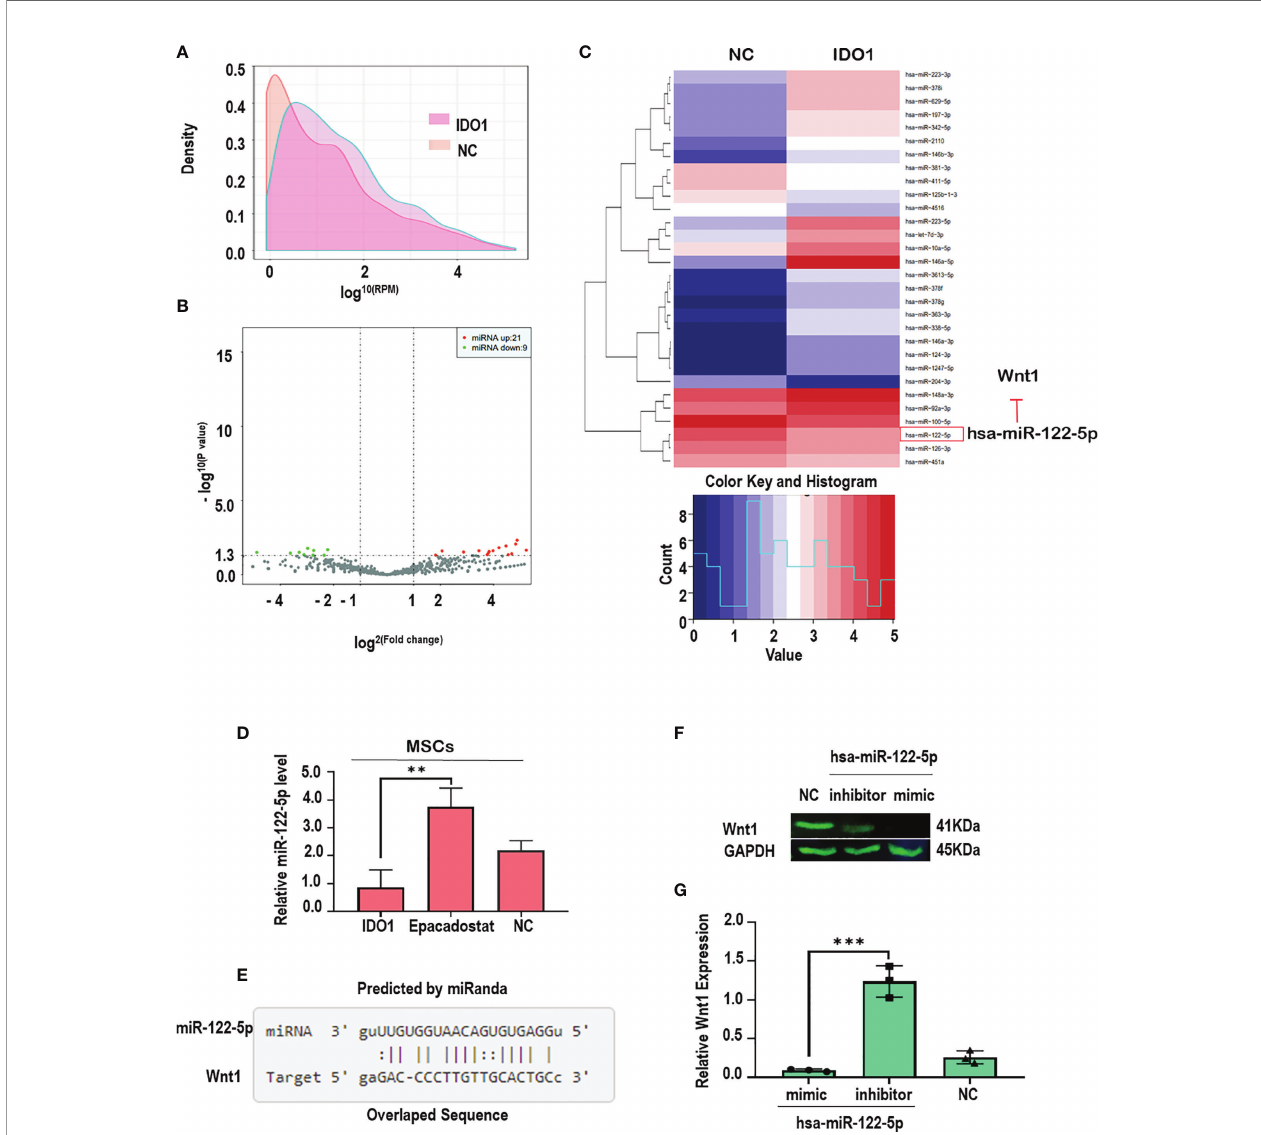
FIGURE 6 | IDO1 impairs chondrogenic differentiation of MSCs by activating Wnt1/ b -catenin throughdownregulation of miR-122-5p. (A,B) The density and distribution of miRNA inthe total RNA obtained from MSCs-treatedIDO1 compared to normal. (C) The screeningof up-/downregulated miRNA, which shows the downregulation ofmiR- 122-5p under the effectof IDO1. (D) The levelsofmiR-122-5p inthe MSCs treated with Epacadostat compared to IDO1 and NC cells. (E) The target sequence of miR-122- 5p inthe sequence of the Wnt1 gene. (F) The expression ofWnt1 protein under miR-122-5pmimics compared to miR-122-5pinhibitor. (G) qPCR con fi rmative experiment for Wnt1 expression under miR-122-5p mimics compared to inhibitor inthe MSCs. *** p < 0.001, and ** p < 0.01 vs